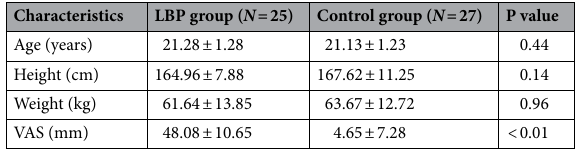
Table 1. Subject characteristics. Data are expressed as mean ± SD. LBP low back pain, VAS visual analogue